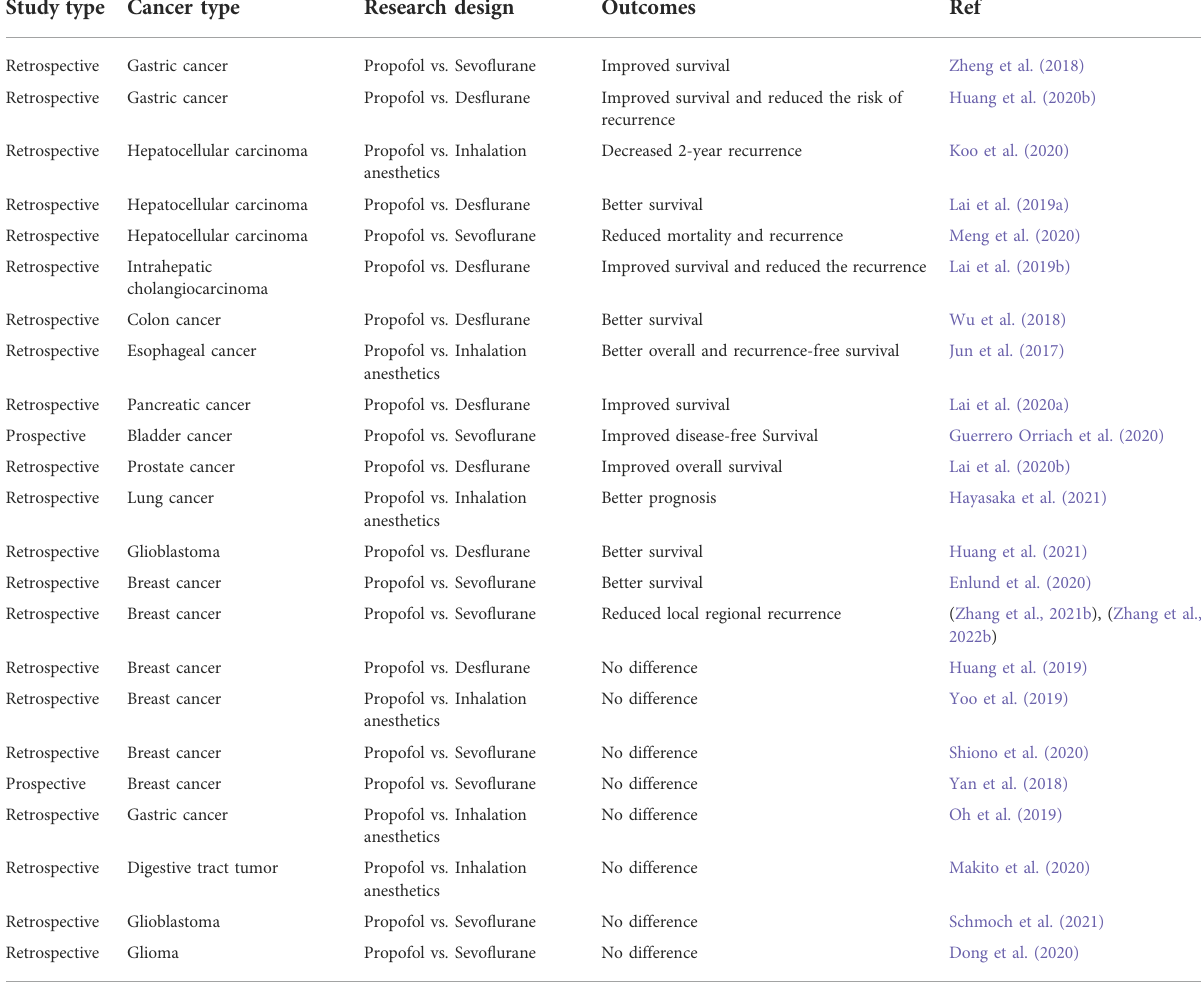
TABLE 2 The effects of propofol on postoperative prognosis of